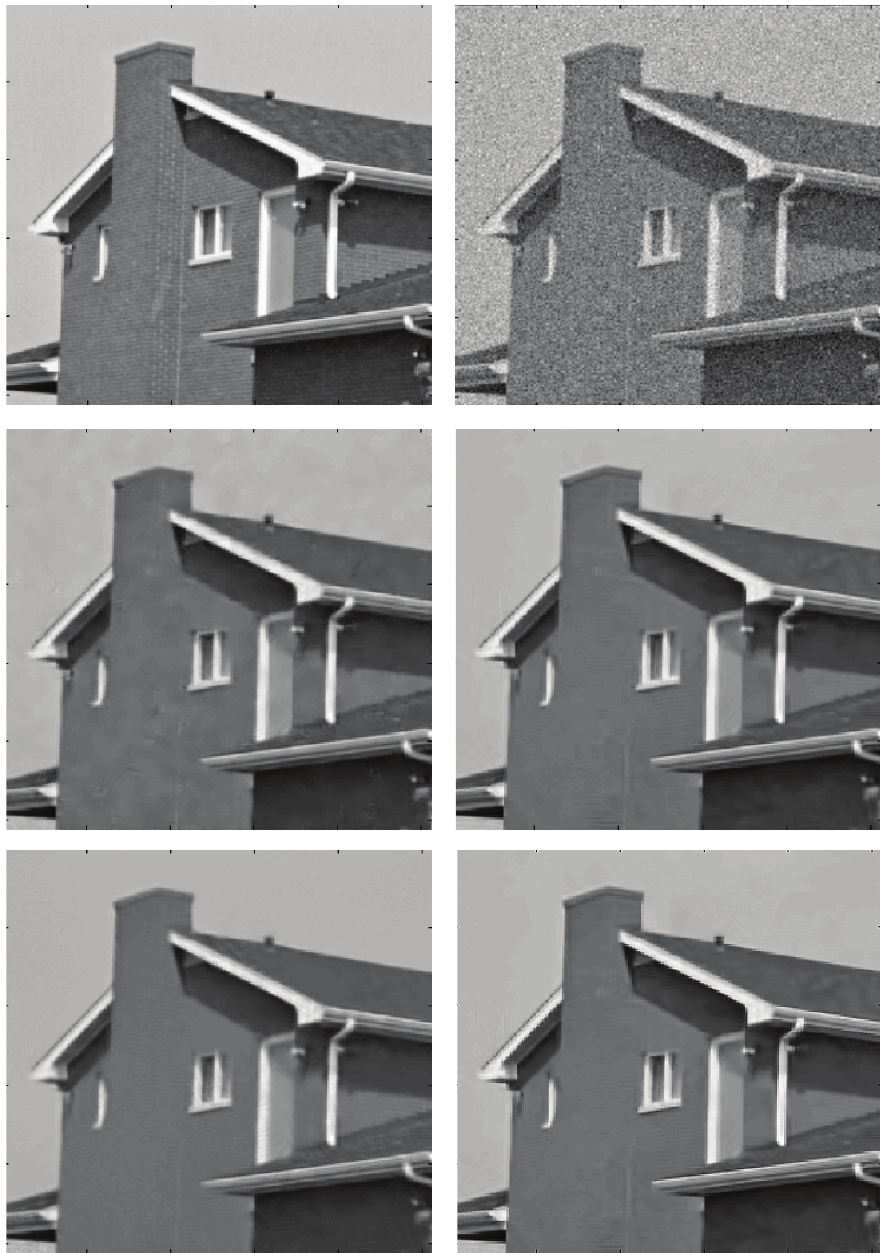
Figure 4: The denoising results of house by different schemes with 𝜎 = 20